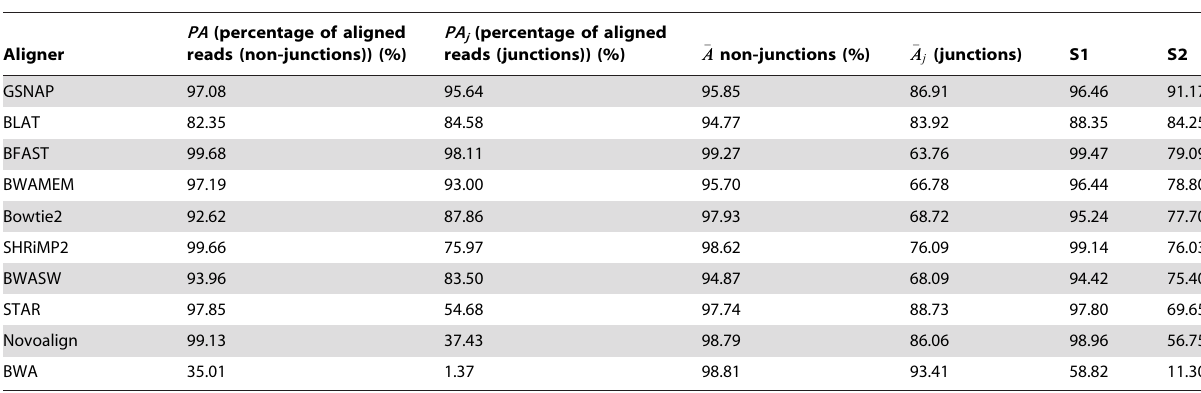
Table 7. Summary of S1 and S2 scores for the human reference genome.